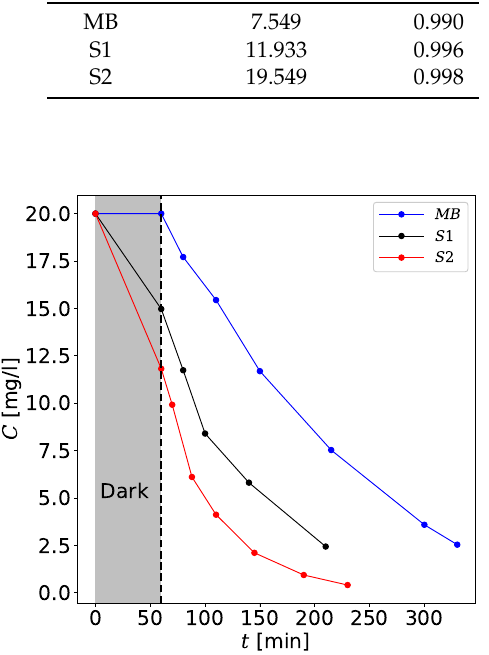
Figure 8. MB concentration C as a function of during irradiation with a UV lamp. The plots represent degradation of MB with the photocatalysts S1 and S2, and without them. “Dark” denotes the period of time when the UV lamp was turned